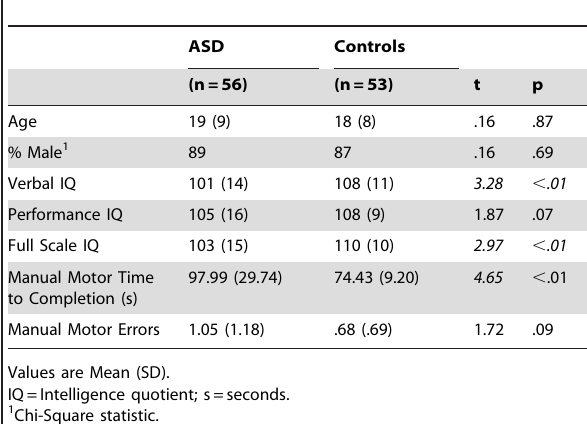
Table 1. Demographic characteristics of individuals with autism spectrum disorders (ASD) and healthy control